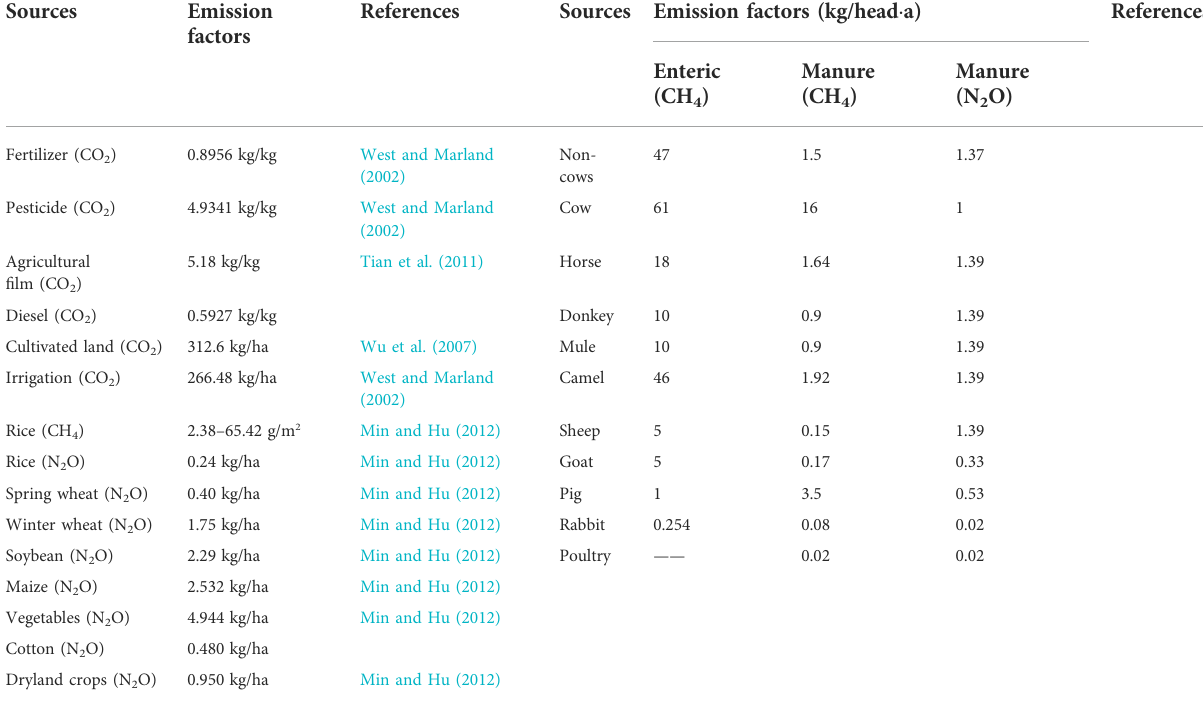
TABLE 1 Greenhouse gas emission factor of different carbon